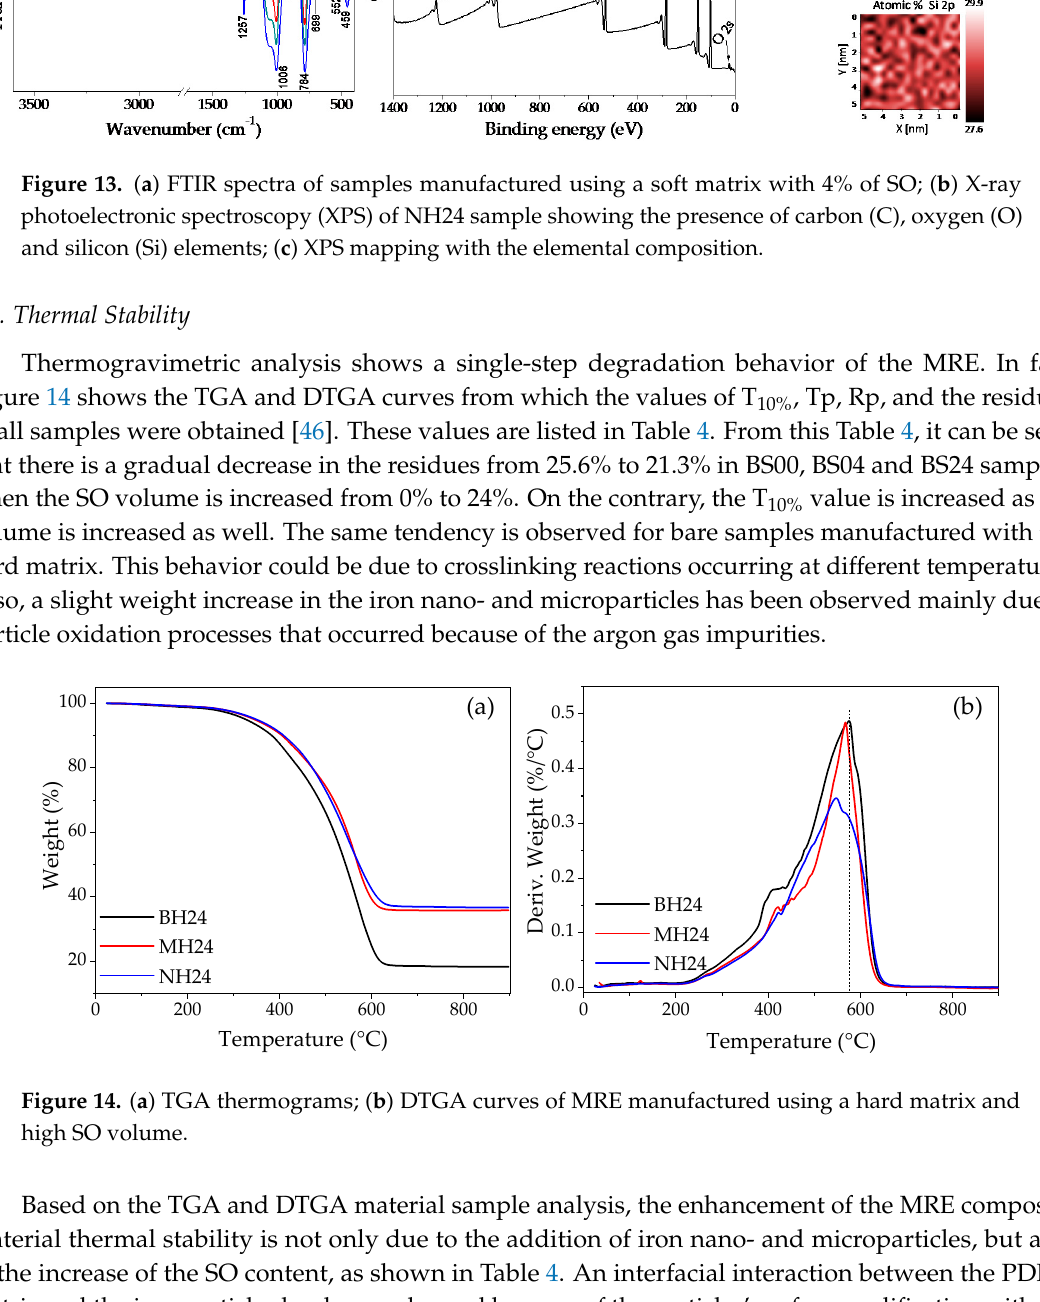
. Figure 15. Computed interaction parameter values from Equation (3), compared to those reported by Chahal [47] and by Schuld [48].